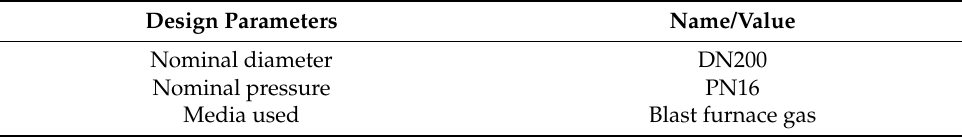
Table 1. Butterfly valve working conditions parameters.